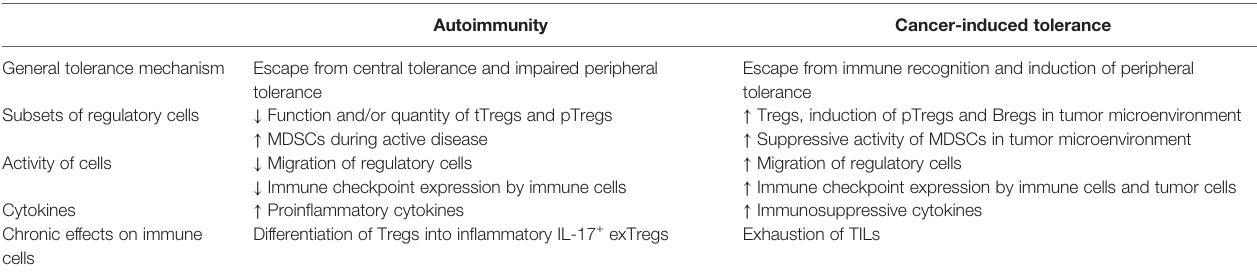
TABLE 1 | Mechanisms involved in breaking tolerance to self-tissues and in induction of cancer tolerance.